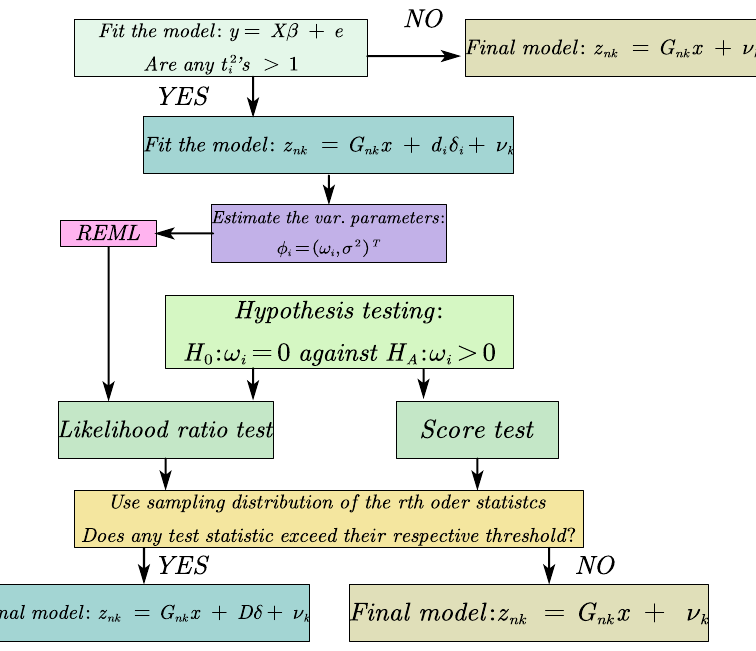
Figure 2. A flow chart of detecting faulty measurements without prior information about potential anomalous measurements based on